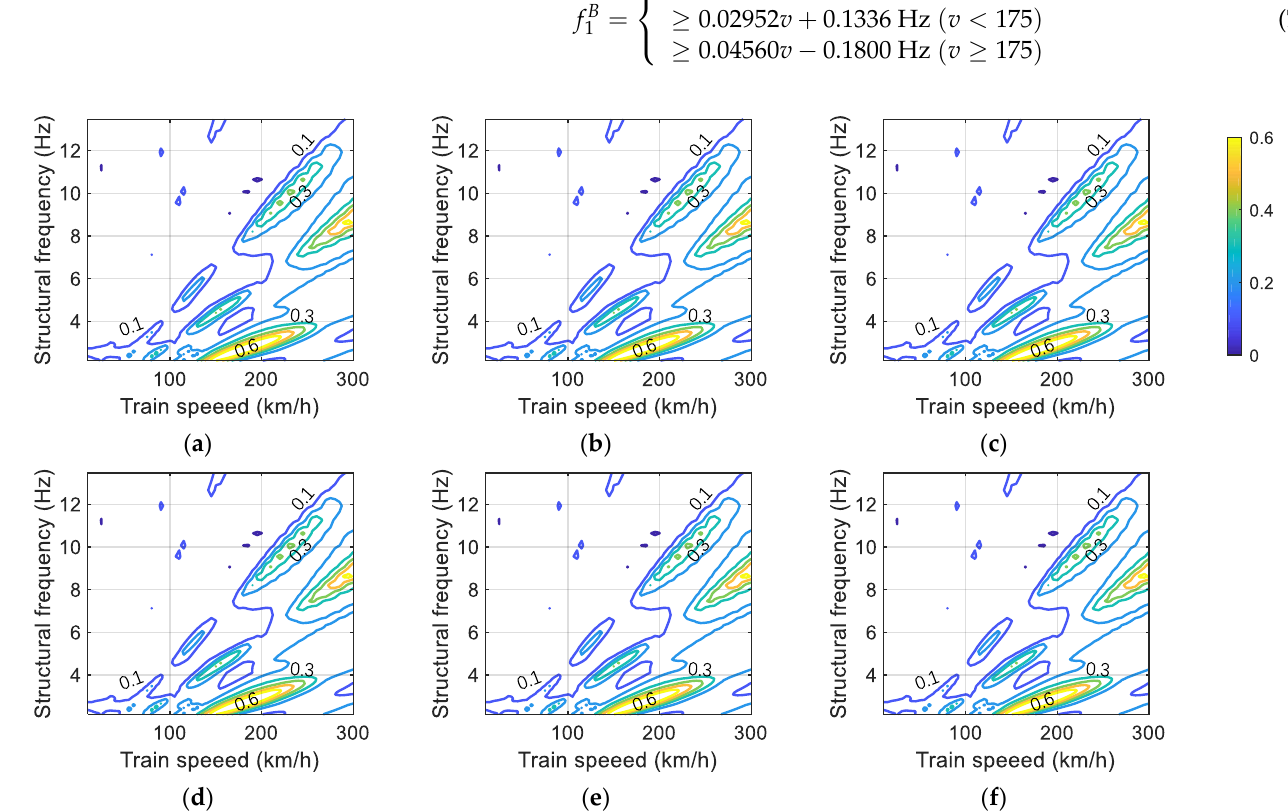
Figure 10. Vertical IF of the bridges under varying frequencies and curved radius: ( a ) R = 400 m; ( b ) R = 500 m; ( c ) R = 600 m; ( d ) R = 700 m; ( e ) R = 800 m; ( f ) R = 900